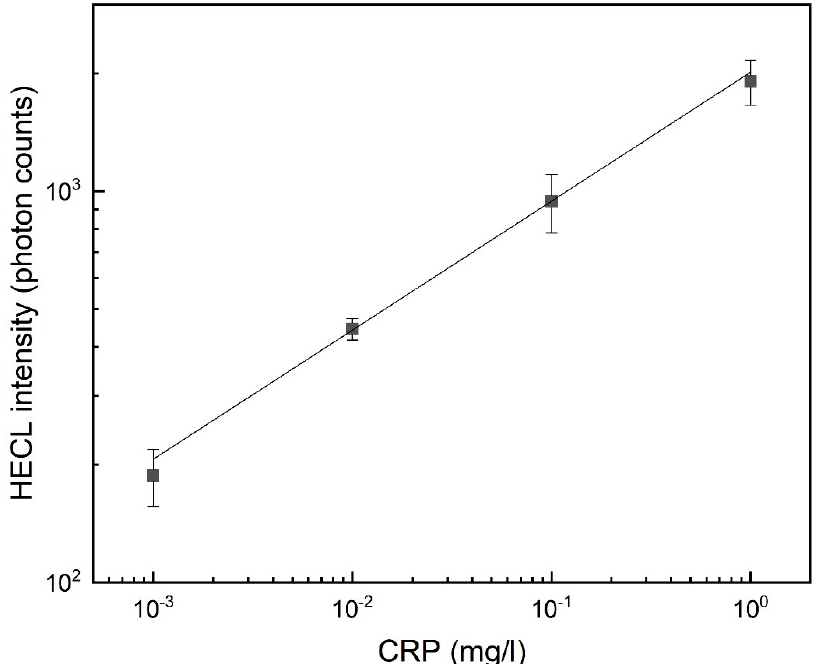
Figure 7. Blank subtracted calibration curves of C-reactive protein (CRP) with 15 min incubation time and 15 µL sample volume. 0.01 M NaN 3 in 0.05 M Na 2 B 4 O 7 , 0.1 M Na 2 SO 4 . FITC 100 ng/cell. Conditions: 500 excitation pulses, pulse charge 31.5 µC, voltage − 55 V, frequency 50 Hz, delay 0 µs and gate 4 × 10 − 5 s. Interference filter (550 ± 10 nm). Measured with RS EC-CB electrodes. Confidence bars calculated with 95% confidence level, n = 2.